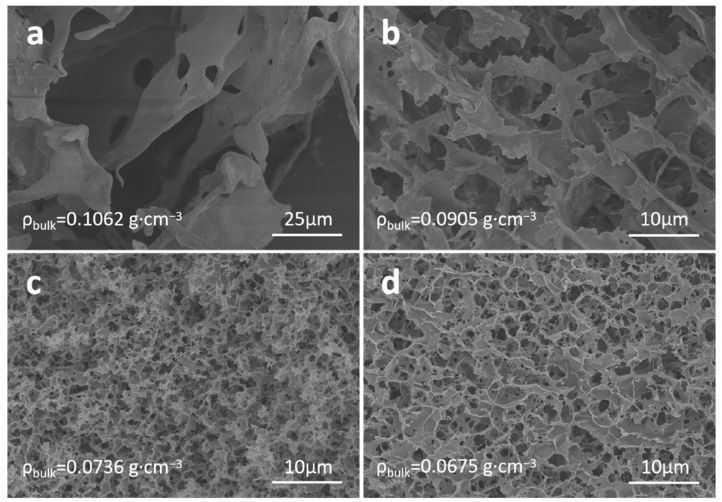
Figure 2. SEM images of cellulose aerogels prepared in NaOH/urea solution with different cellulose concentrations: ( a ) 1 wt%, ( b ) 2 wt%, ( c ) 3 wt%, and ( d ) 4